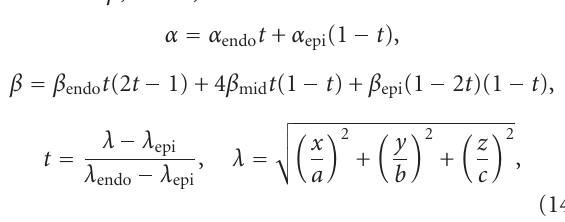
n s is normal to the plane of myofiber (cid:0)